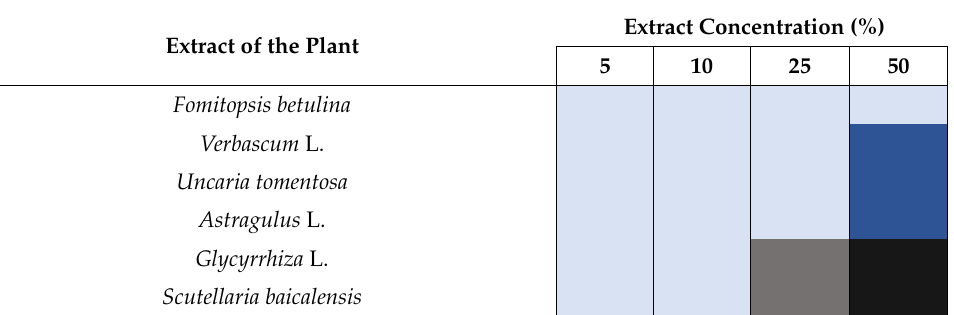
Extract Concentration (%)